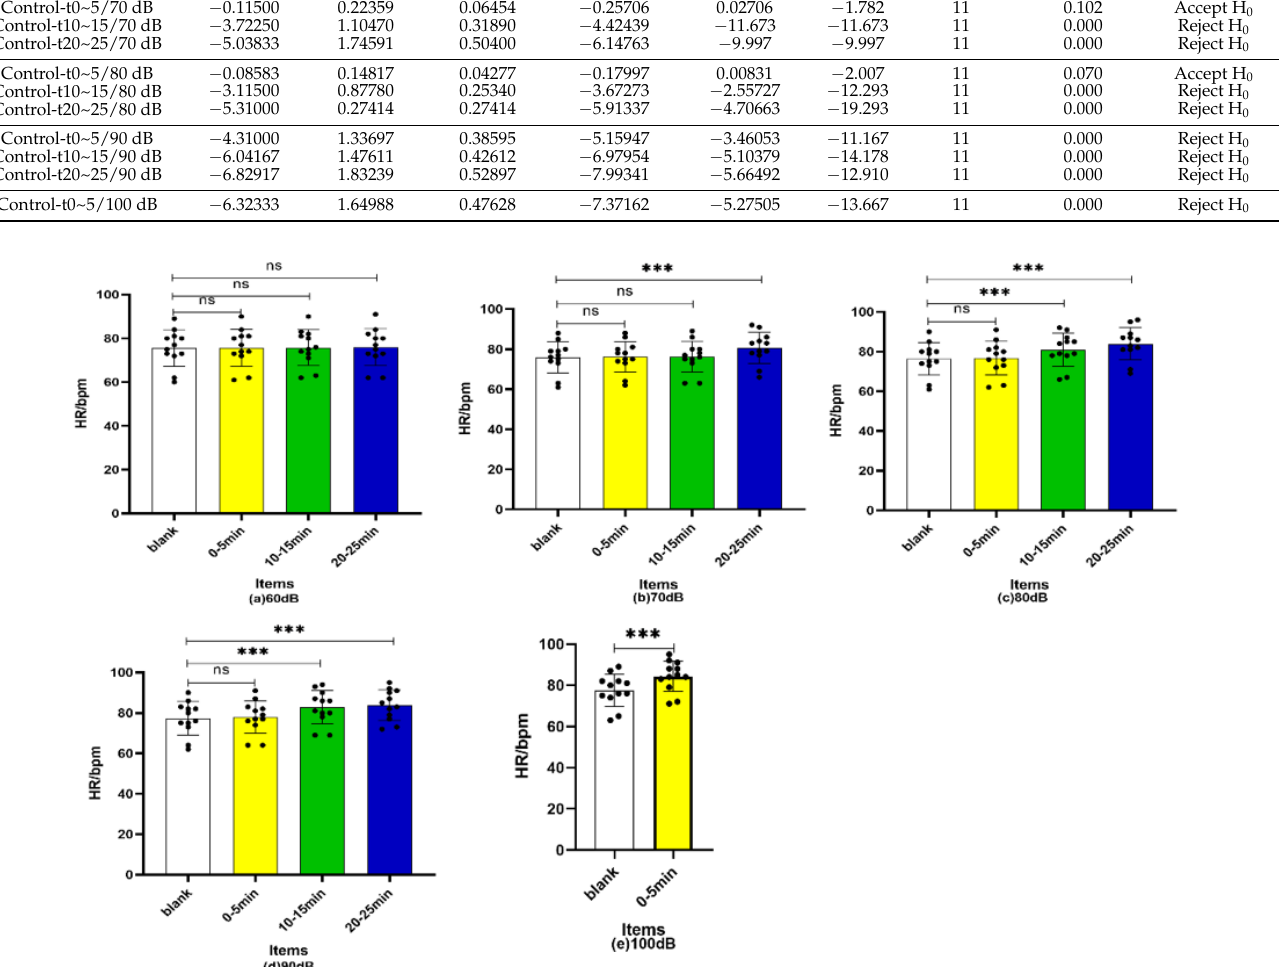
Figure 4. Bar graph of heart rate under five noise levels. “ns” means no significant difference, “***” means have significant